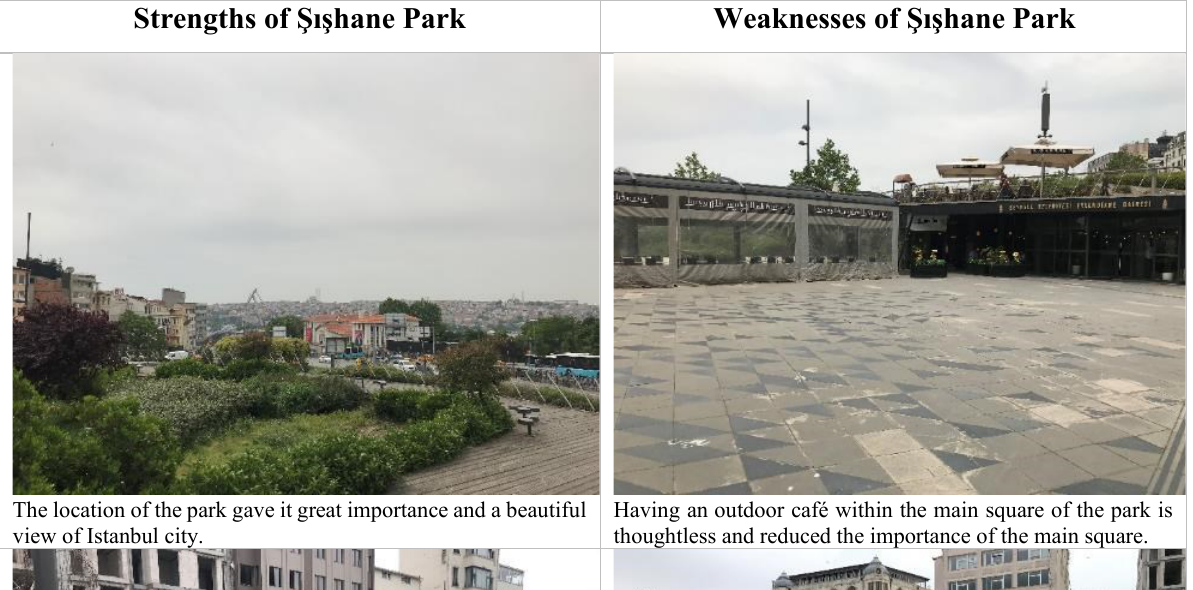
Table 5. Highlight the strengths and weaknesses of "Şışhane Park"; (Improved by author; Figures source: by authors) . Strengths of Şışhane